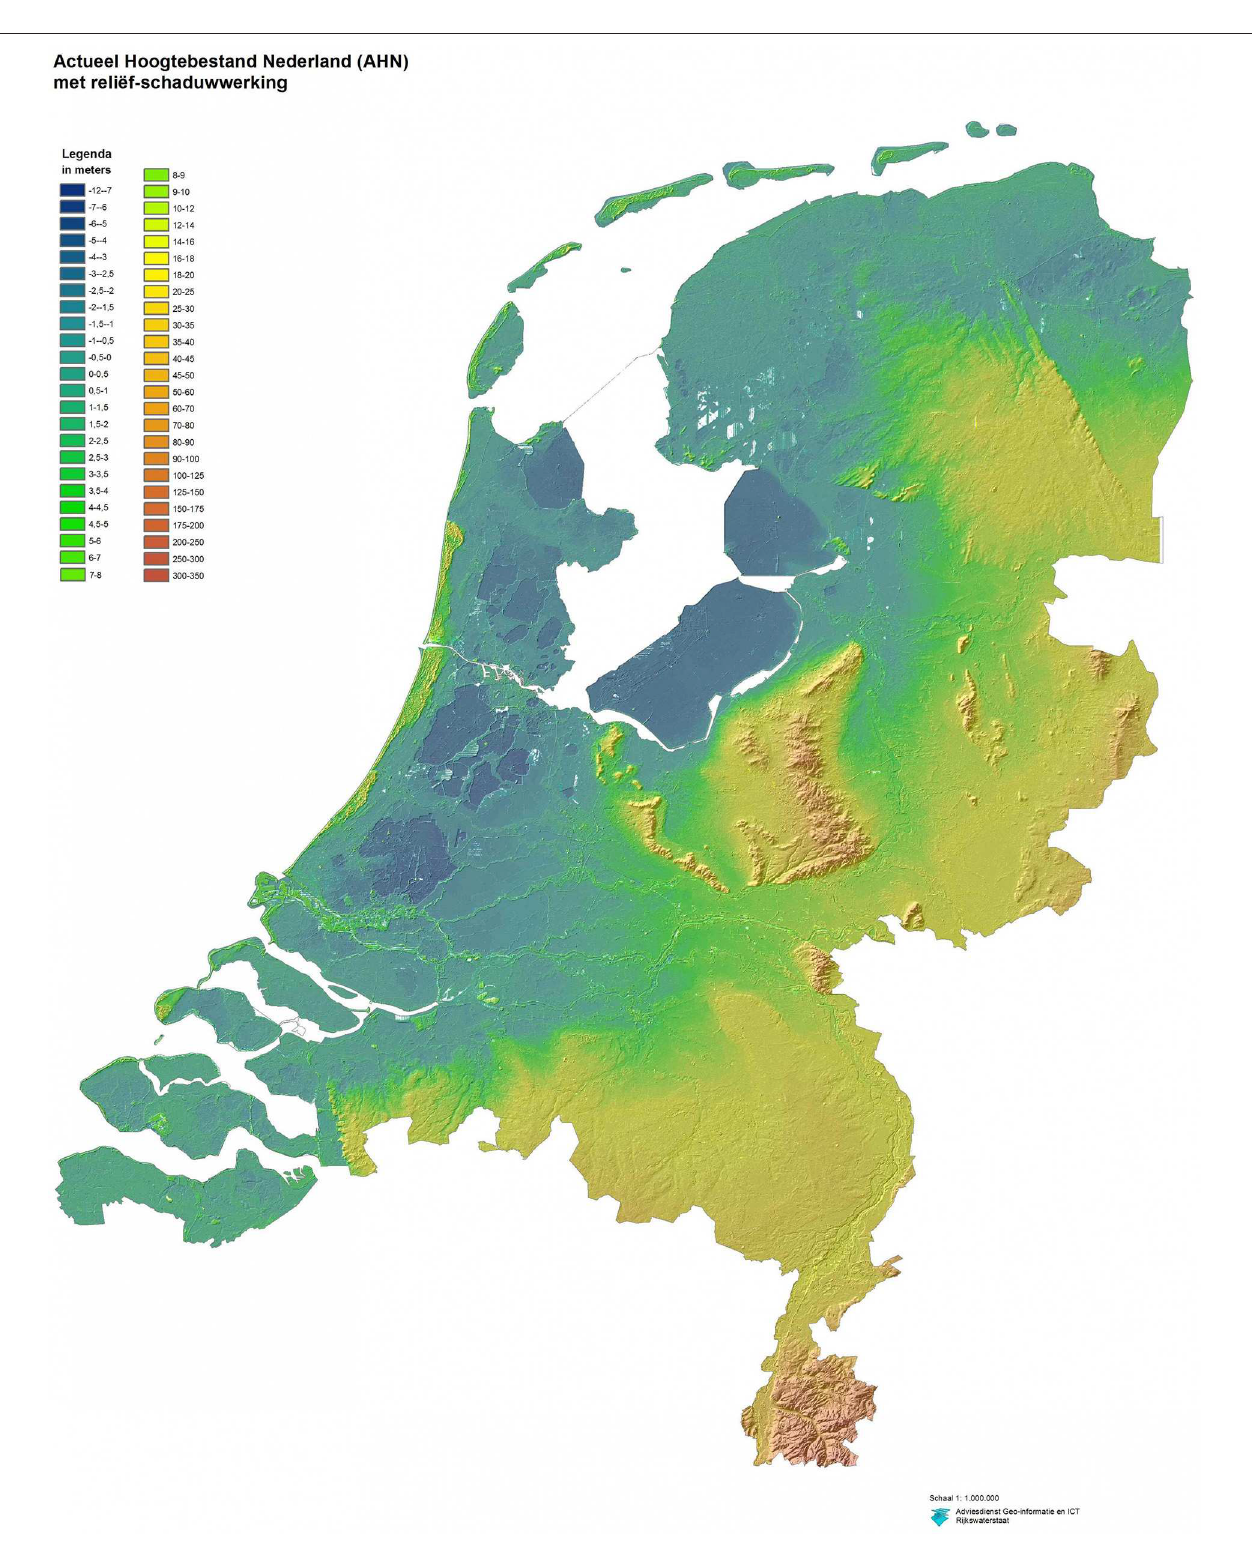
FIGURE 3 | The Netherlands’ topography. The darkest blue areas are 7–12m below sea level, while the deepest red areas reach 350m above sea level. Gold areas are 25–40m above sea level. Source: Netherlands Topographic 3D Map MakerEdChallenge 2 0 by mitrasmit, thingiverse.com.